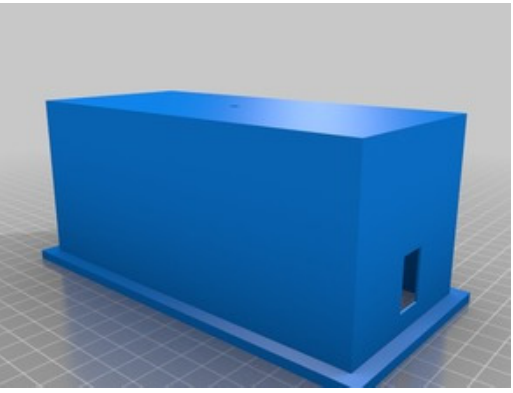
Figure 5. Rendering of OpenSCAD solid model for the battery casing for the MOST delta RepRap PV conversion kit.